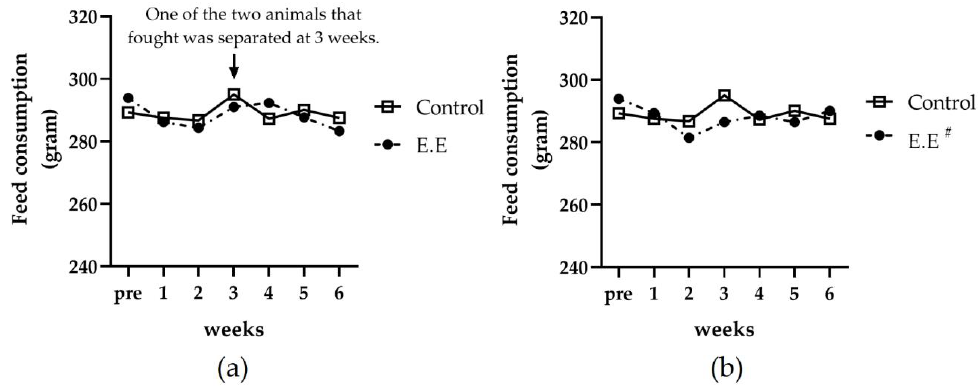
Figure 4. Feed consumption at 1-week intervals, including before environmental change of placing them into the cages (pre) for a total of 6 weeks when the separated fighting dog was ( a ) included and ( b ) not included. # Except for the one dog that fought. E.E: Environmental enrichment group. 2 weeks: 0.93 ± 0.54, 4 weeks: 1.27 ± 0.53, and 6 weeks: 1.38 ± 0.21 µg/dL). In the E.E group,